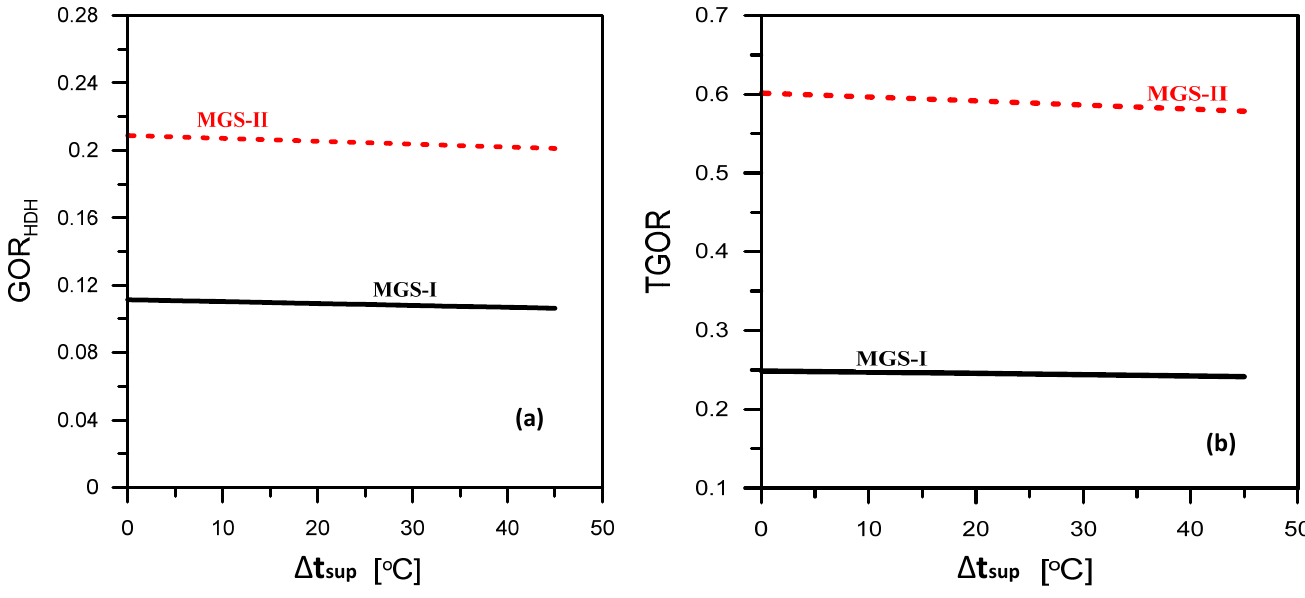
Figure 5. Impact of ORC superheat degree on the proposed systems’ performance: ( a ) GOR HDH ; ( b ) TGOR.